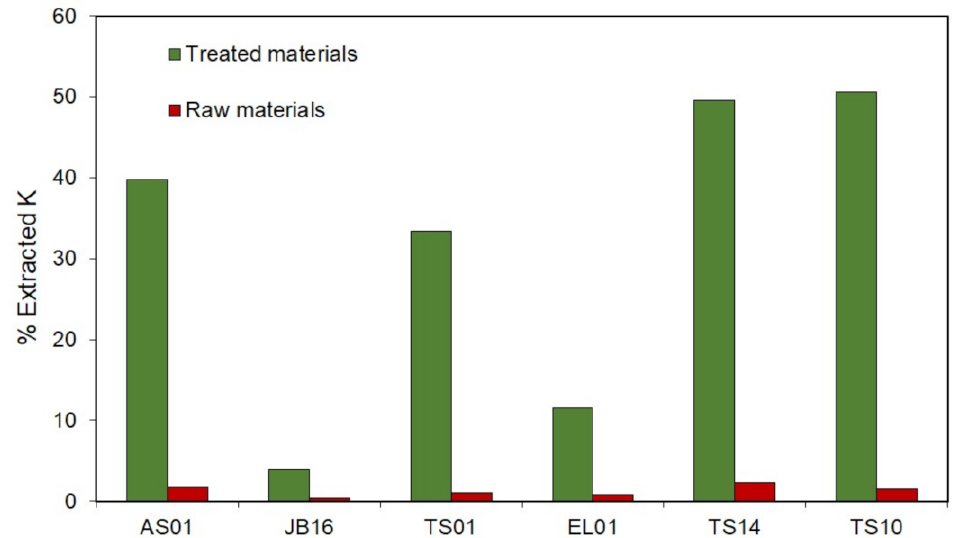
Figure 12. Potassium extraction percentage for raw and treated